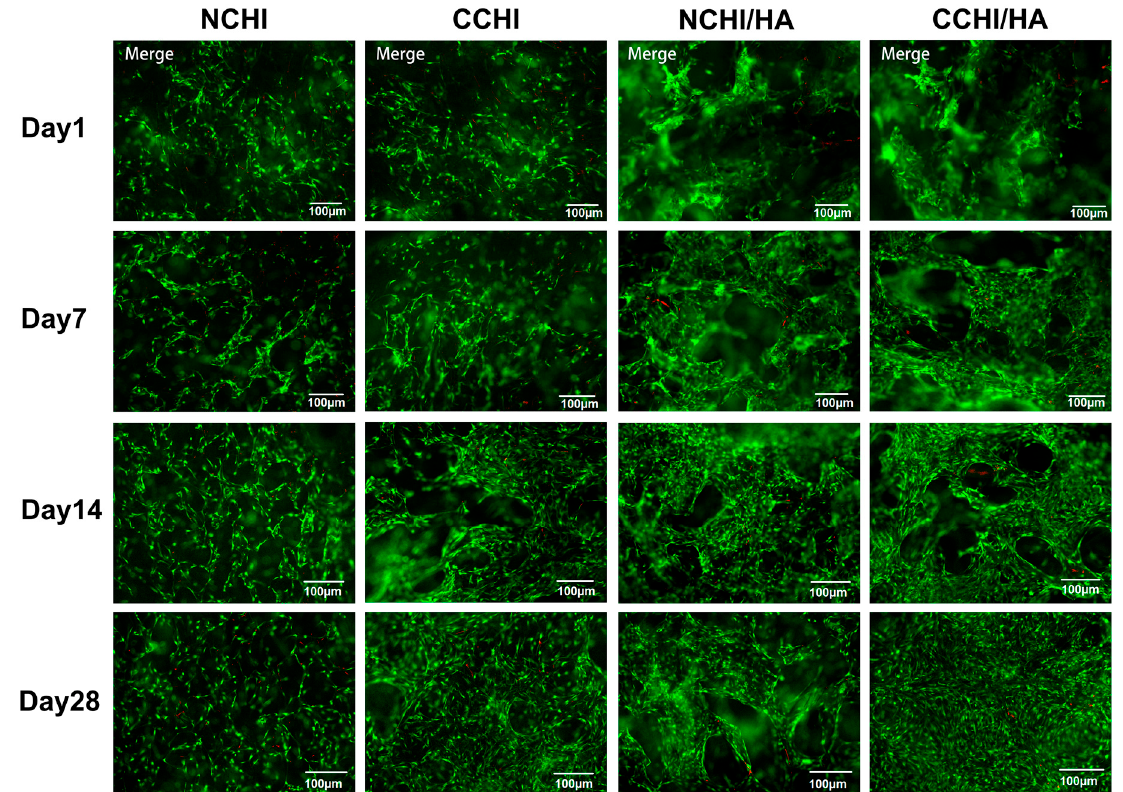
Figure 4. Fluorescent microscopic images of the live/dead cell survival assay in CHI and CHI/HA groups cultured for 1, 7, 14, and 28 days in either N = normal or C = chondrogenic medium. Living cells fluoresce green and dead cells fluoresced red . Magnification set at 10×.